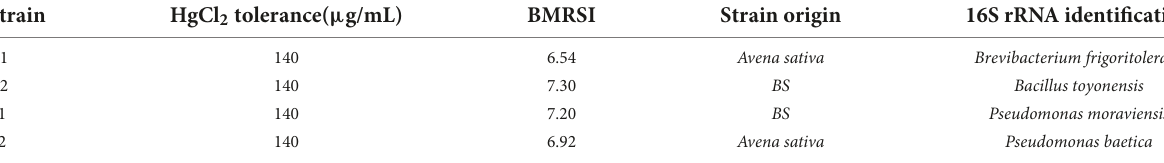
TABLE 1 Bacterial isolates according to their BMRSI in the presence of Hg (González et al., 2021b).